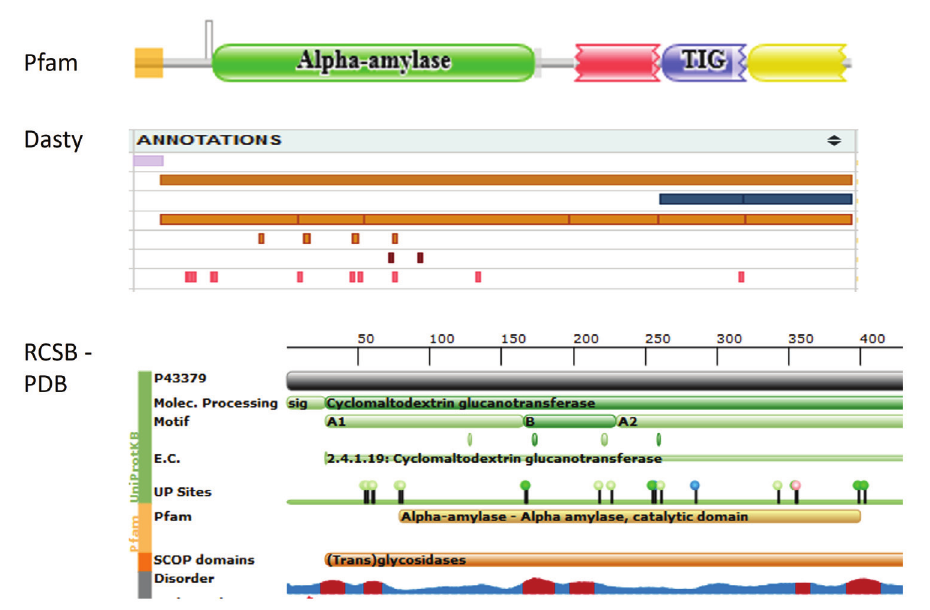
Figure 1. Visualization of a portion of the protein P43379–UniProt accession, in Pfam, Dasty and